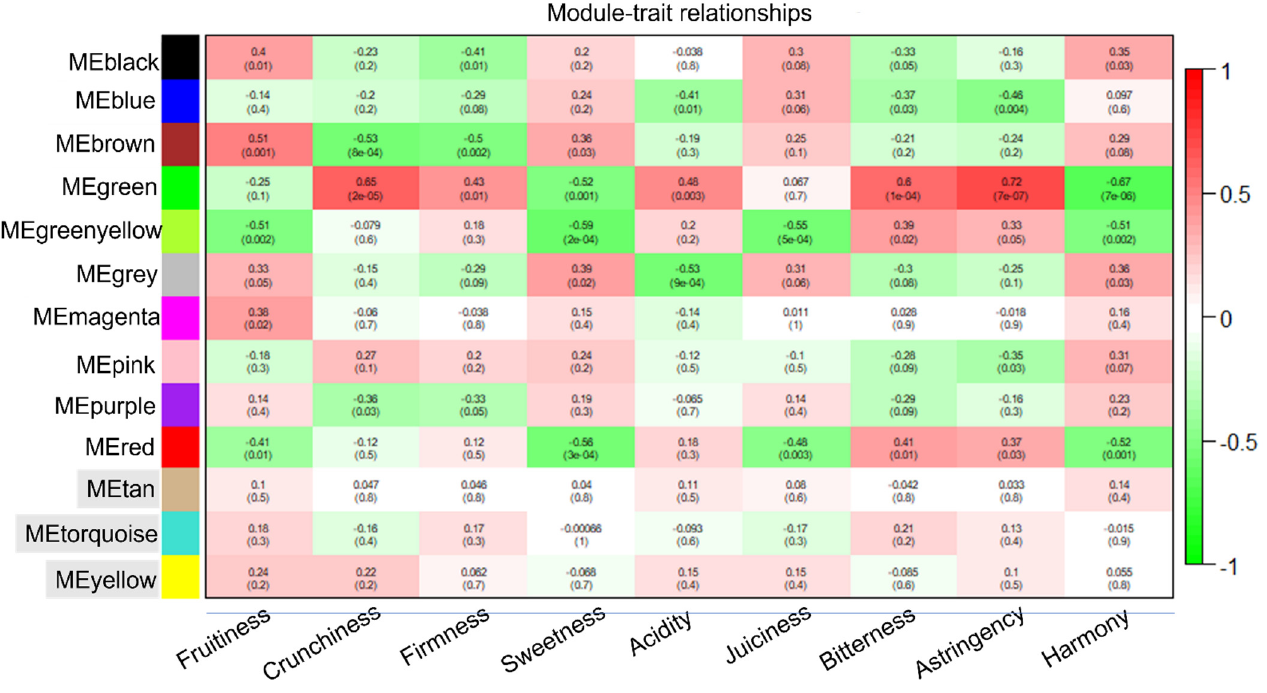
Figure 3. WCNA (Weighted Correlation Network Analysis) showing module–trait relationships. Pearson coefficient and p -value (in brackets) are reported. Module names shaded grey indicate lack of significance across all traits.